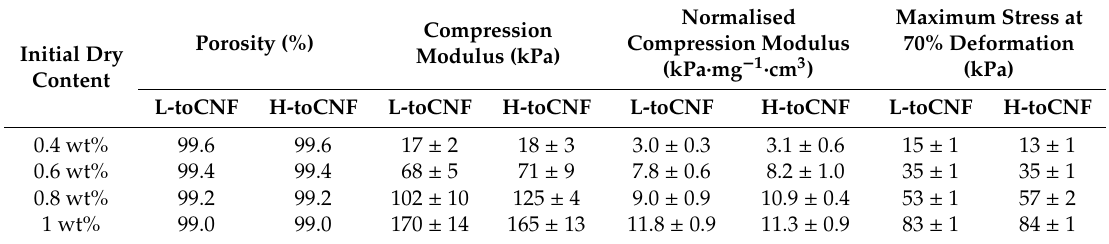
Figure 6. Relative density dependence of the compression modulus, normalised compression modulus, and maximum stress at 70% deformation for L-toCNF and H-toCNF cryogels. Table 4. Mechanical properties for toCNF at various